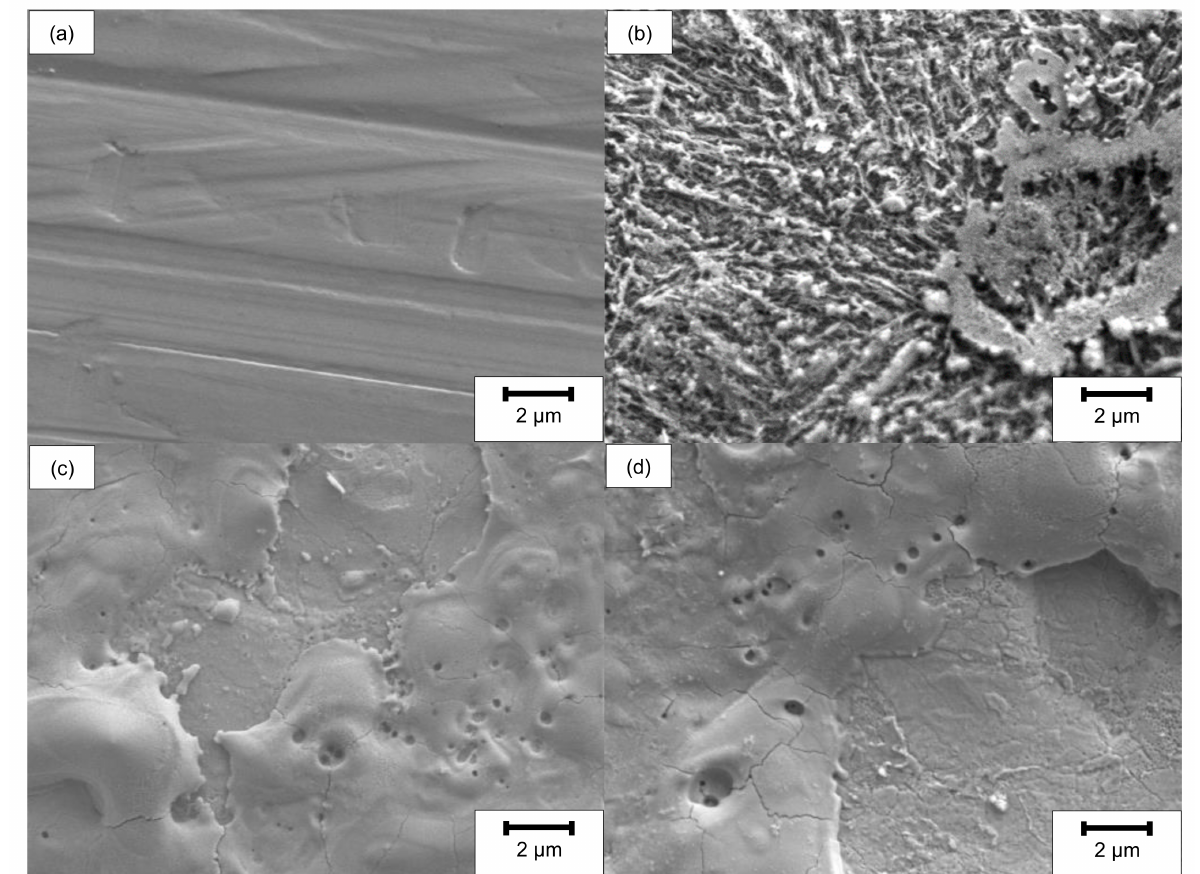
Figure 2. SEM top-view images before oxidation of ( a ) ground, ( b ) LCM-H 3 PO 4 -6W, ( c ) LCM-NaNO 3 -6W and ( d ) LCM- NaNO 3 -18W 42CrMo4